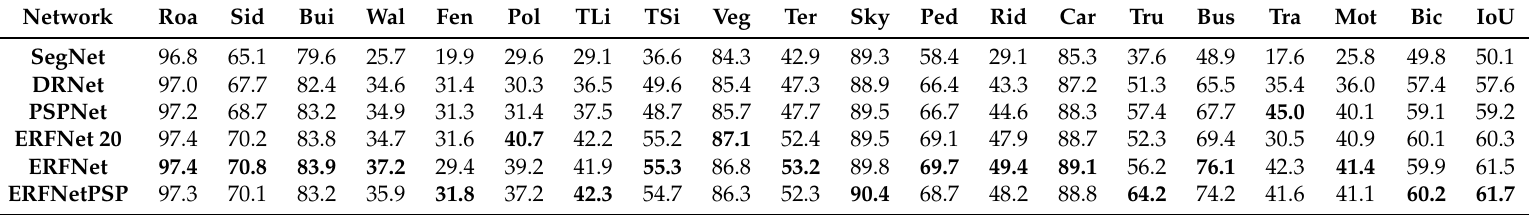
Table 4. Per-class IoU (%) on the fisheye CityScapes validation set compared to similar works.